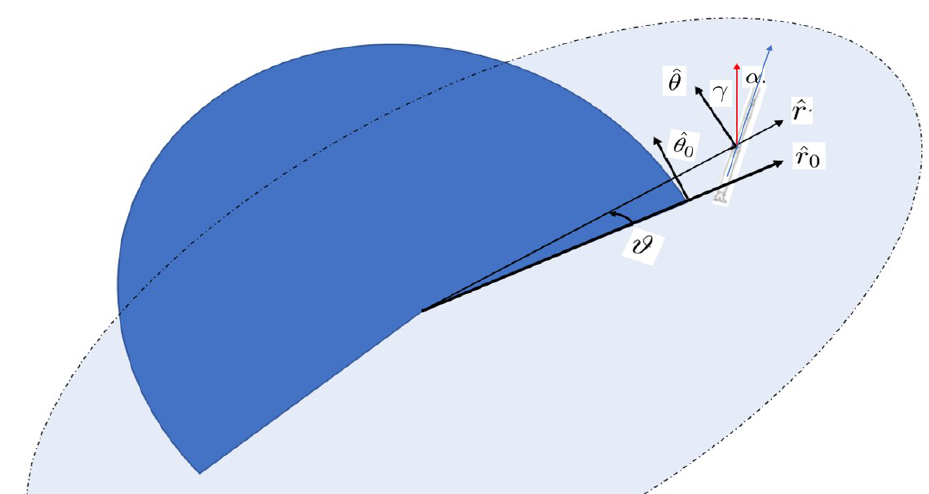
Figure 1. The state variable of the launch trajectory. The inertial frame (ˆ r 0 , ˆ θ 0 ) has origin on the centre of the Earth (in dark blue). The orbit frame (ˆ r , ˆ θ ) has origin on the launcher centre of mass. The red arrow defines the velocity and the blue arrow the thrust